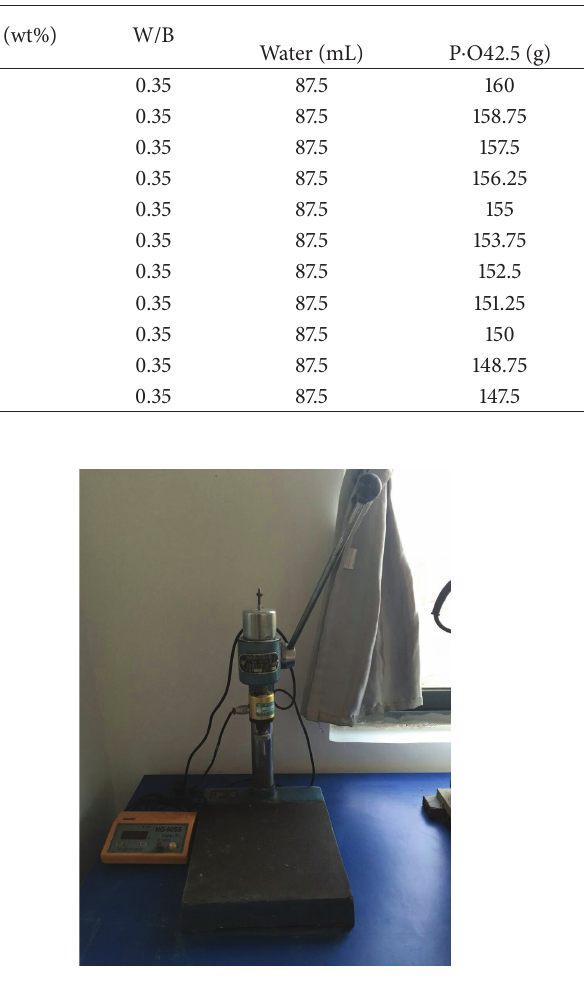
Figure 4: Concrete penetration resistance tester. Figure 5: Apparatus to measure the fluidity of cement